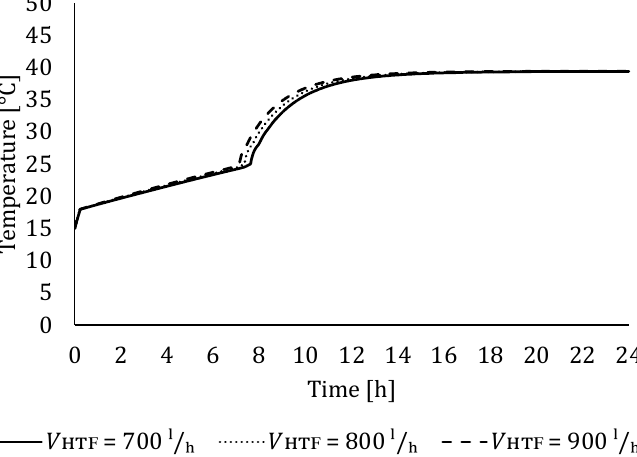
Figure 19. Comparison of transient variations of PCM temperatures during melting obtained nu- merically for different HTF flow rates, HTF inlet temperature 40 °C and initial PCM temperature 15 °C.